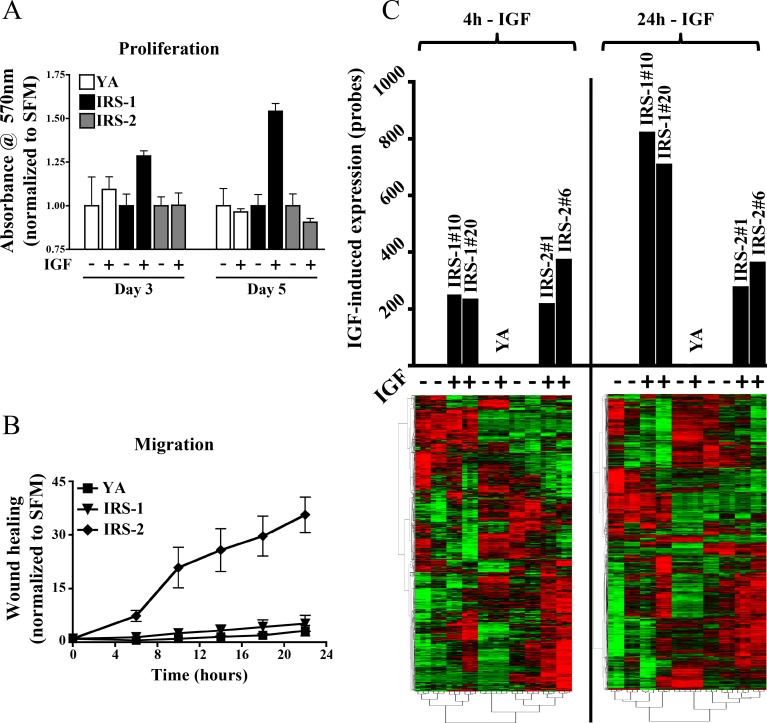
IRS adaptor protein isoforms define tumor cell biology and regulate global gene expression profiles.(A) Monolayer growth and motility of T47D-YA (YA), T47D-YA-IRS-1 (#10 and #20) and T47D-YA-IRS-2 (#1 and #6) were measured by MTT assay and (B) scratch-wound healing assay in response to IGF-I treatment. The graphs are presented as fold-change response vs. non-treated control and error bars represent standard deviation. (C) IGF-induced gene expression is IRS-dependent. cDNA microarray analysis was performed on IRS-null YA, IRS-1, and IRS-2 clones. The graph represents IGF-regulated probes in comparison to untreated samples that met both fold (1.5) and p-value (0.05) cutoff values. Hierarchical clustering was carried out on log2-transformed using Gene Cluster 3.0 and visualized in Java TreeView.